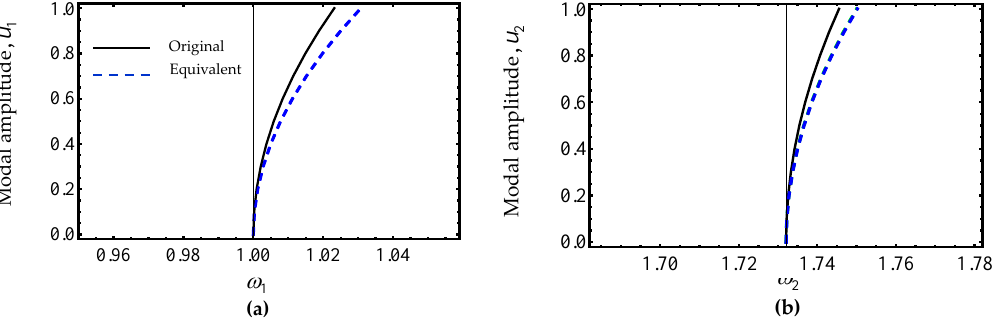
Figure 1. Modal amplitudes: ( a ) u 1 vs ω 1 , ( b ) u 2 vs ω 2 . The backbone curves were computed from Equations (33) to (35). The parameter values used to obtain these plots were m 1 = m 2 = 1, k = 1, ε = 0.5 with c = 0 and f 1 = 0. Here, the black solid lines describe the solutions obtained from Equations (34) and (35), while the blue dashed lines represent the backbone curves computed from Equation (33).